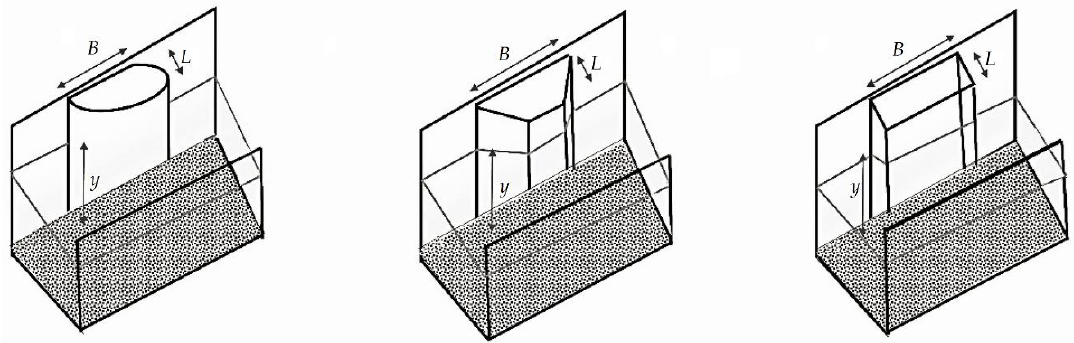
Figure 1. Schematic of the different abutment in the flume. L and B are the abutment length and width respectively. Table 1. Statistical indices for the collected dataset.